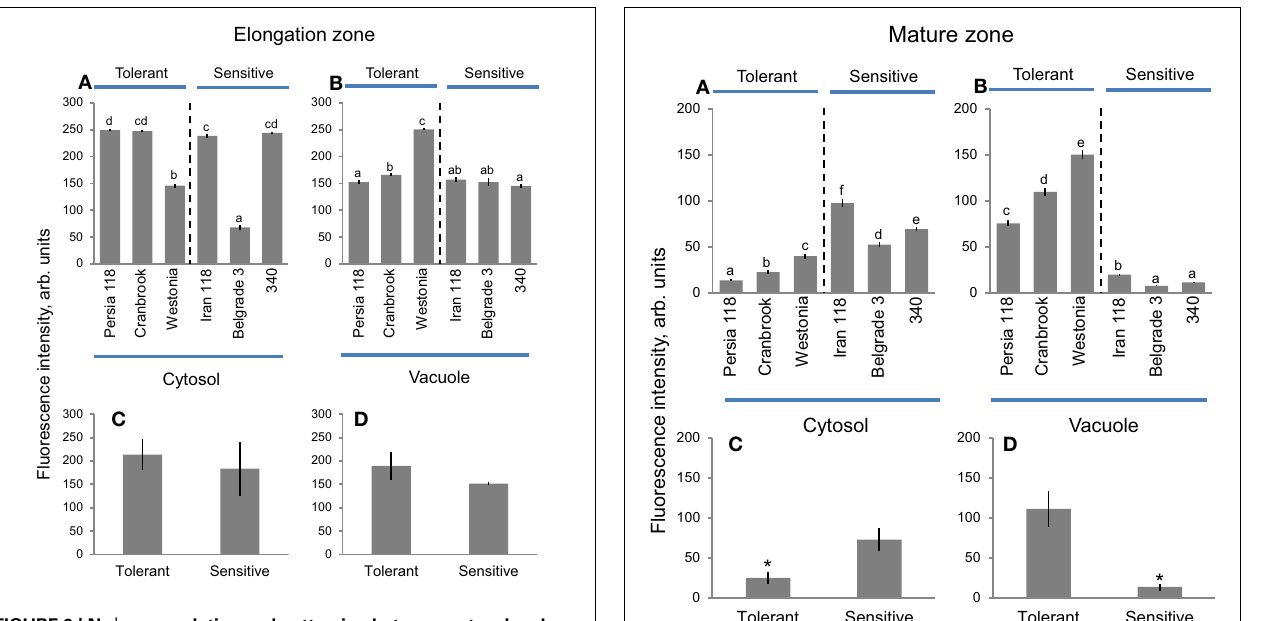
FIGURE 9 | Na + accumulation and patterning between cytosol and vacuole in elongation root zone in bread wheat genotypes. Intensity of CoroNa Green fluorescence in cytosolic (A) and vacuolar (B) compartments (arb. units) in root elongation zone of six bread wheat varieties contrasting in their salinity tolerance. Mean ± SE ( n = 72–96 cells from at least six individual plants). Different lowercase letters represents significant difference between varieties at P < 0 . 05. (C,D) averaged pooled values for cytosolic (C) and vacuolar (D) Na + intensity for salt-tolerant and salt-sensitive clusters shown in A,B . Mean ± SE ( n = 215–300; three varieties × 72–96 cells analyzed for each variety).